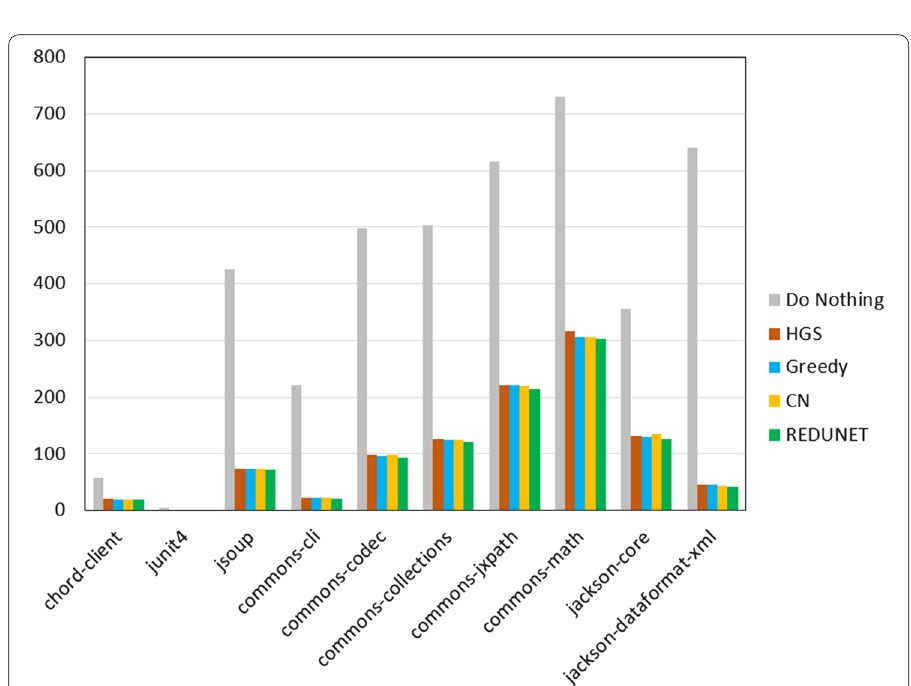
Fig. 6 Effectiveness of our test suite optimisation Running time in seconds of the test suites after the reduction (y-axes). The labels in the x-axis represent the ten software projects under analysis, whose details are reported in Table 2. The series represents the approaches under comparison, whose details are given in Table